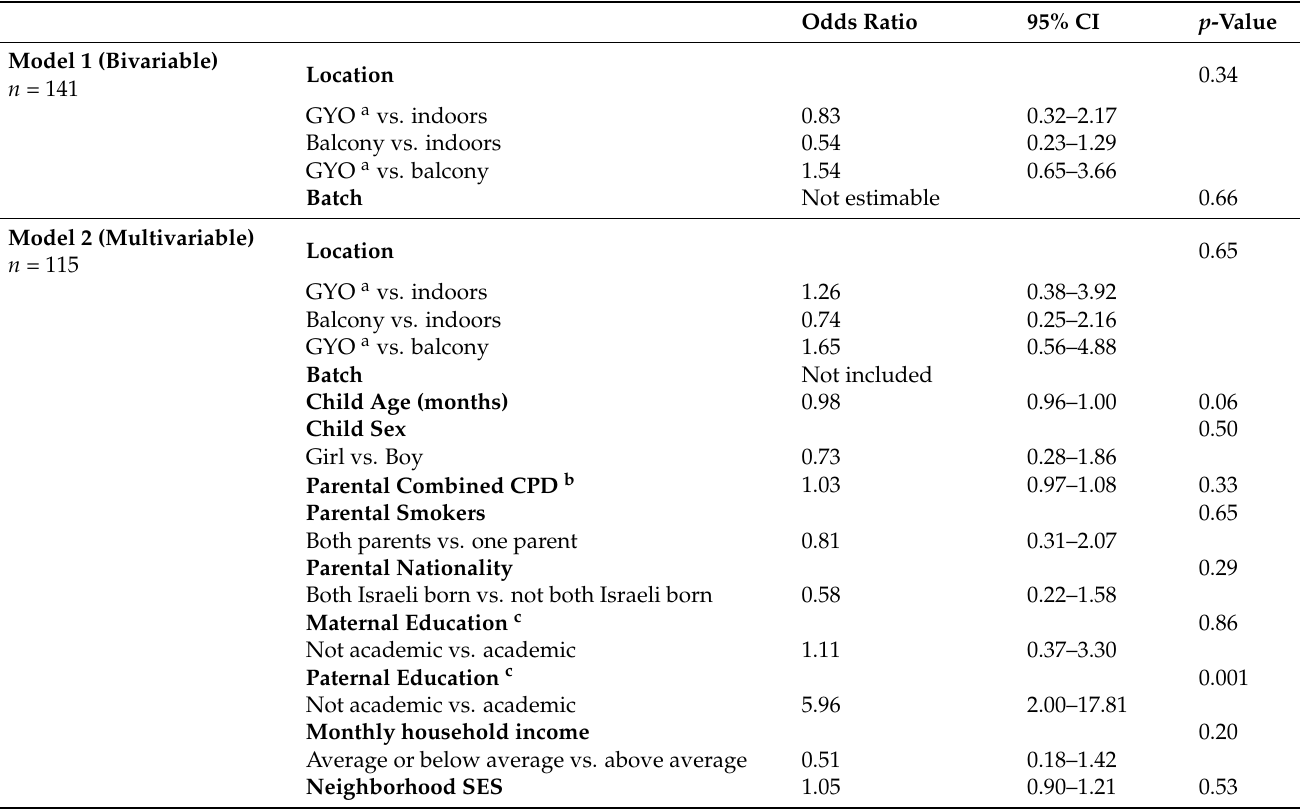
Table 2. Logistic regression analyses examining child exposure as assessed by hair nicotine (exposed vs. unexposed, based on Level of Detection (LOD)), by usual location of smoking. Odds Ratio 95% CI p